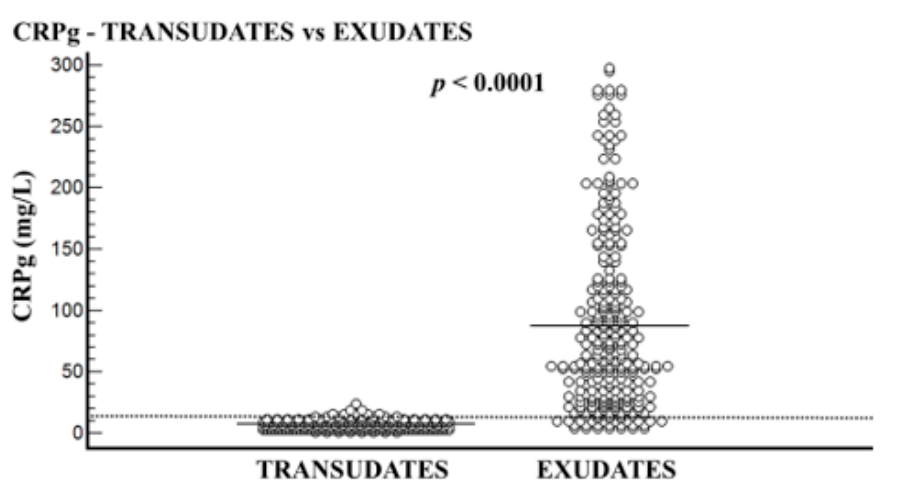
Figure 3. Serum and pleural fluid CRP gradient (CRPg) levels and their means for transudate group (6.7 mg/L) and exudate group (87.2 mg/L), and best cut-off value (13.6 mg/L) for discrimination between the two groups. For both parameters p < 0.0001.